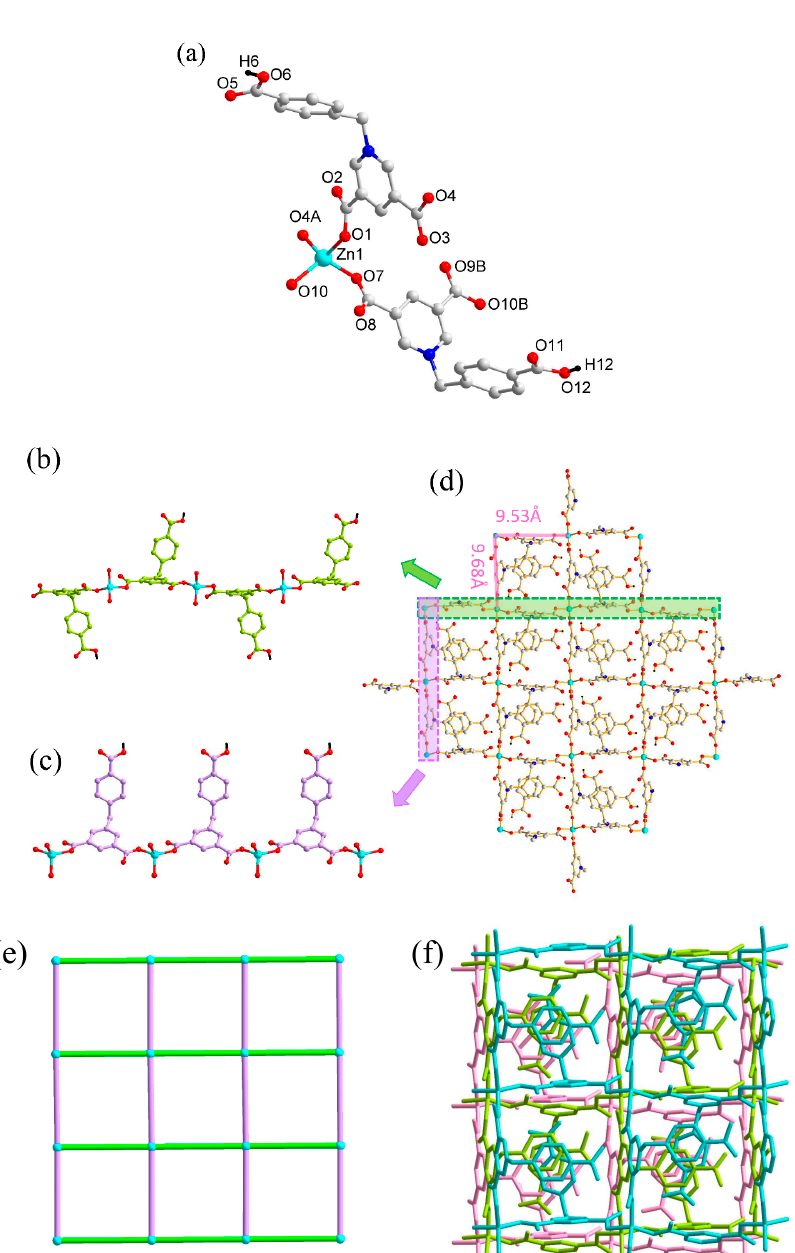
Figure 1. ( a ) Coordination environment of the metal atom and ligand of 1 (symmetry codes: (A) x, y − 1, z; (B) x + 1, − y + 1, z + 1/2; (C) x, y + 1, z; (D) x − 1, − y + 1, z − 1/2). ( b ) 1D chain generated by